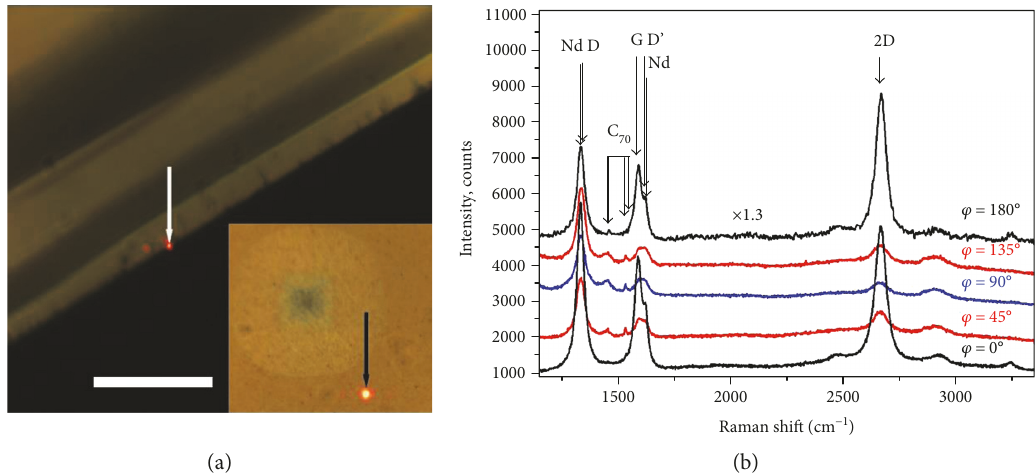
Figure 9: (a) Optical photography of the specimen in X ( YY ) X geometry (in Porto notations). The inset: optical photography of the specimen in Z ( YY ) Z geometry (in Porto notations). The arrow-remarked laser spots are eye guide showing the real area of the laser spot during measurements. The marker represents 10 μ m. (b) Spatially resolved Raman spectra of as-deposited defected graphene at 633nm